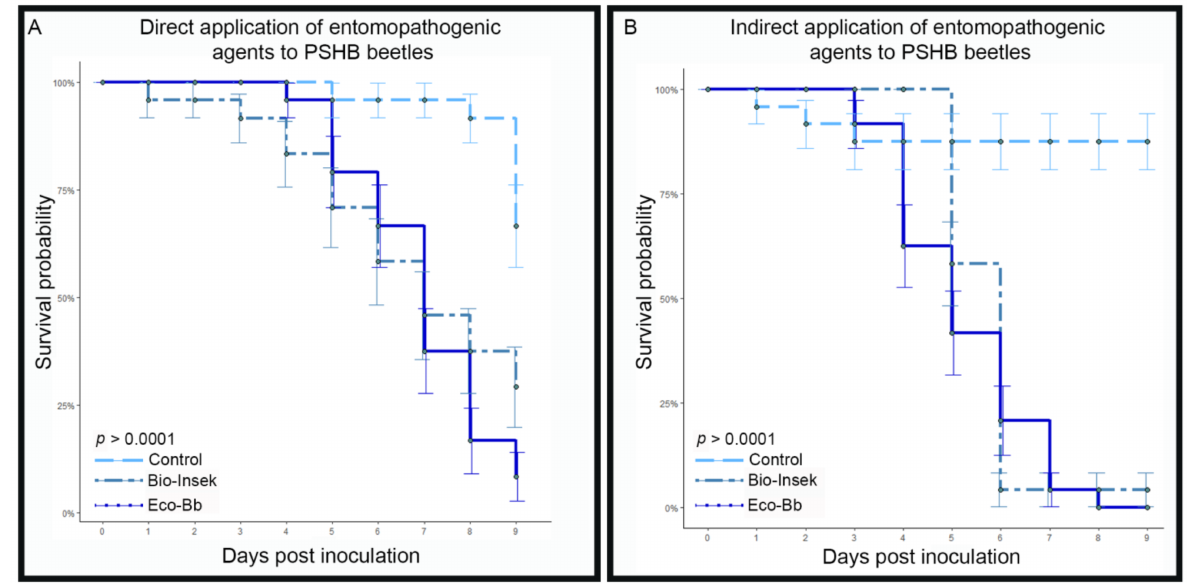
Figure 1. Kaplan–Meier survivorship curves reflecting time until death of PSHB beetles for the laboratory applications assays where ( A ) spore suspensions were applied directly to the beetles, and ( B ) spore suspensions were applied to the filter papers on which beetles were incubated. Beetles used in trial replicates were used as individual units to determine median survival time. Error bars indicate standard error, circles indicate the percentage of live beetles remaining at a given time point.